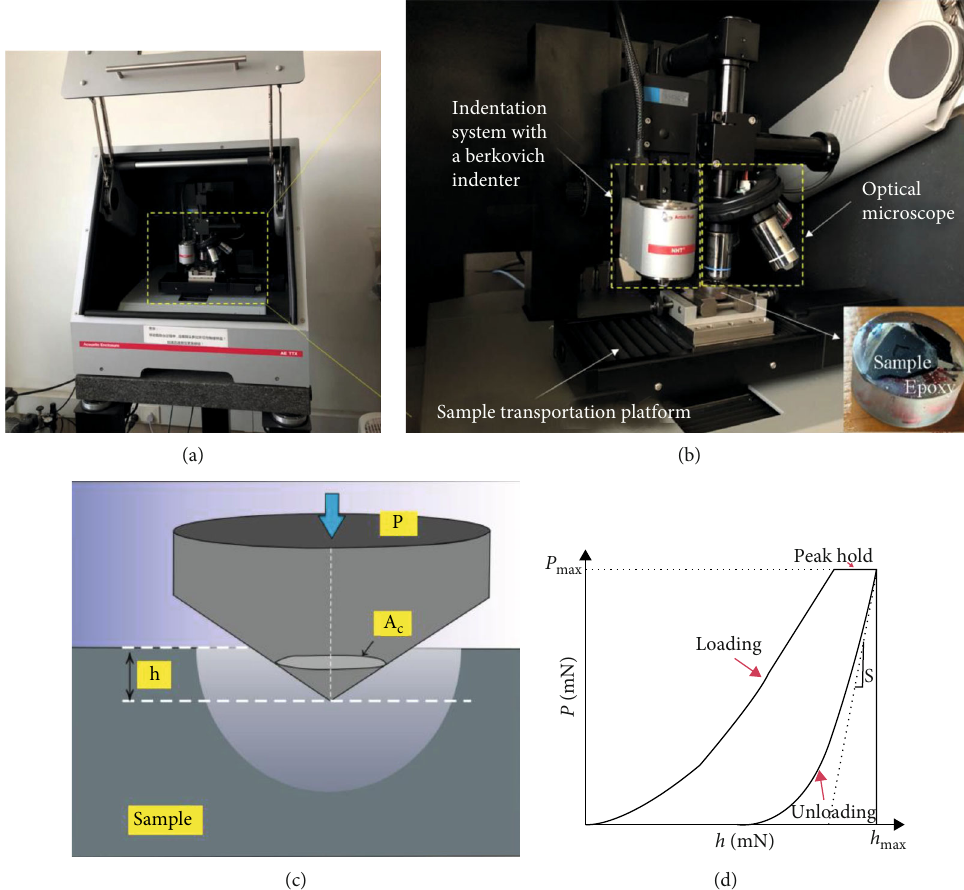
Figure 1: (a) TTX-NHT 3 indentation instrument, (b) the main components of the instrument, (c) schematic diagram of a nanoindentation and (d) typical load – displacement (P – h) curve [14]. P is the applied load, P is the maximum indentation displacement, and h max